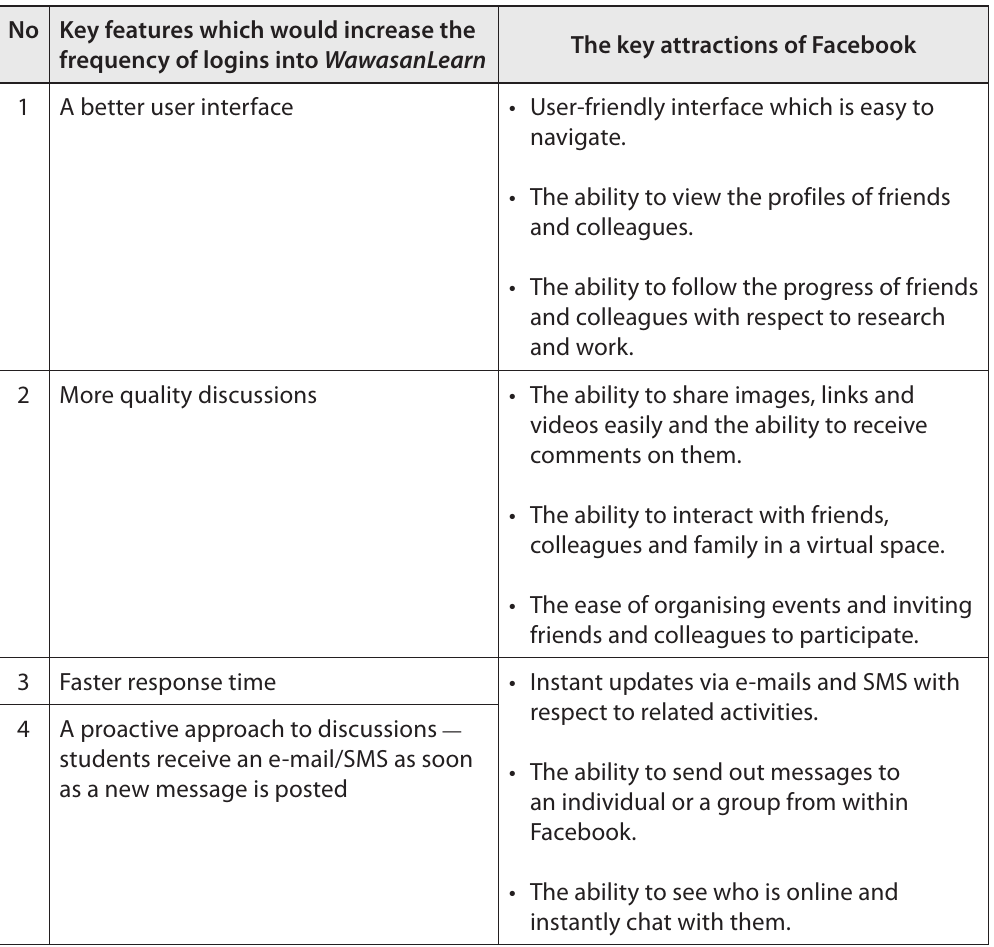
However, by analysing the findings from WOU’s perspective, it was realised that Facebook alone would not be able to effectively serve the needs of the adult ODL students. Therefore, a hybrid approach, which marries the pedagogical soundness of the Moodle-based WawasanLearn with the social interactivity of Facebook, was